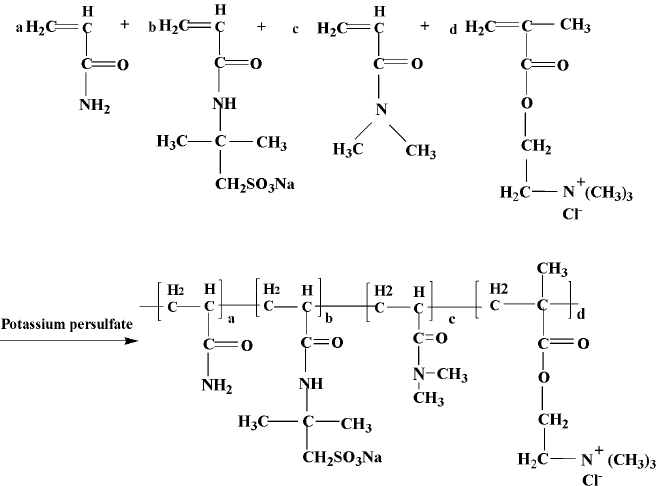
Figure 1. Reaction schema of the copolymer PADAD.